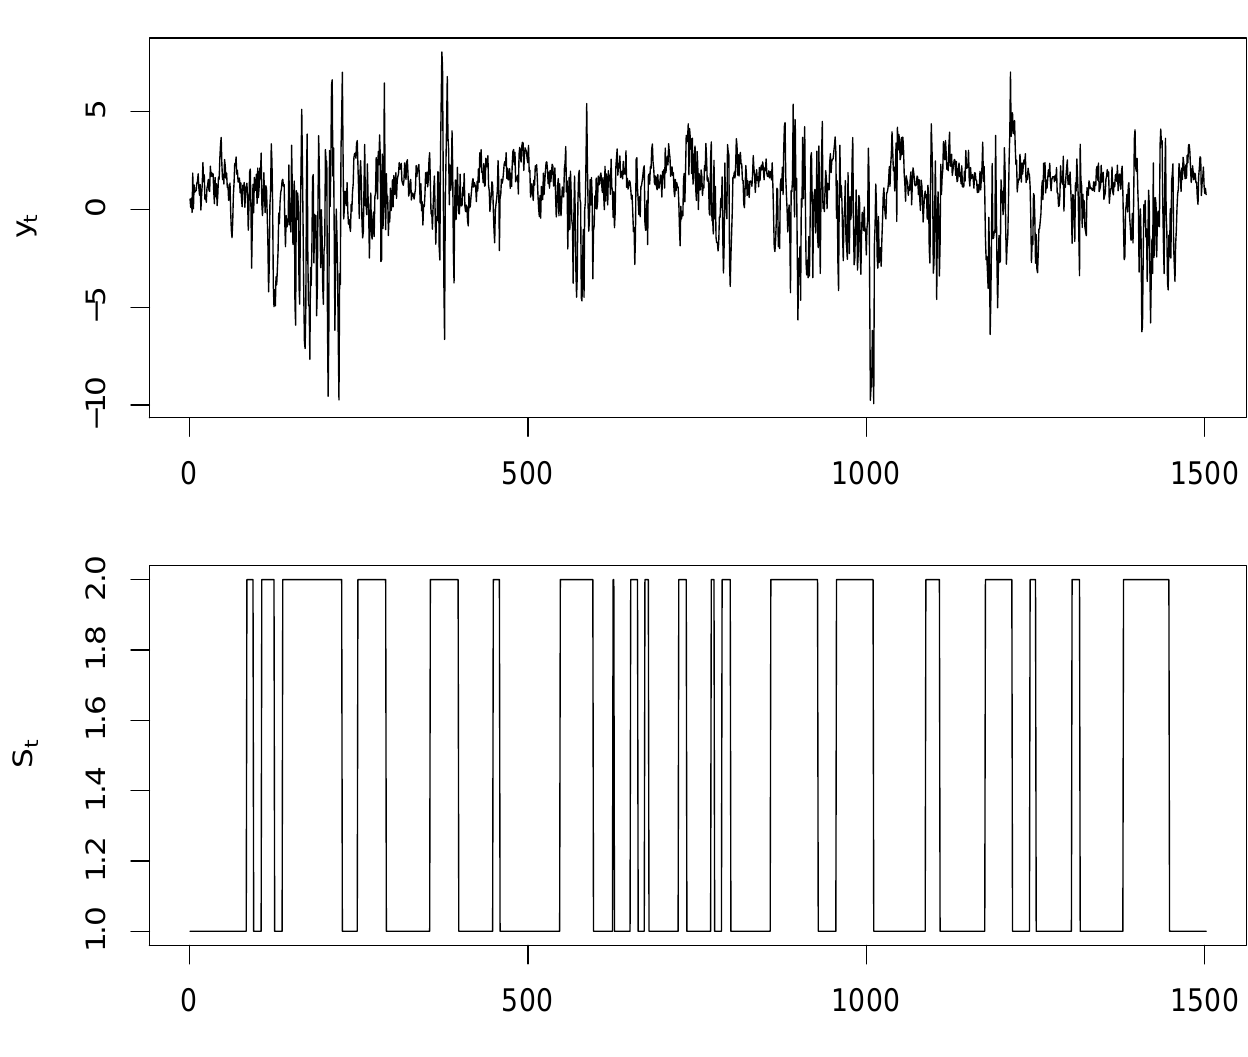
Figure 4. Simulation of a MS(2)-AR(2)-GARCH(1,1) whose coefficients and transition probability values are given in Table 1. Top: simulated process y = ( y regime sequence S = ( S